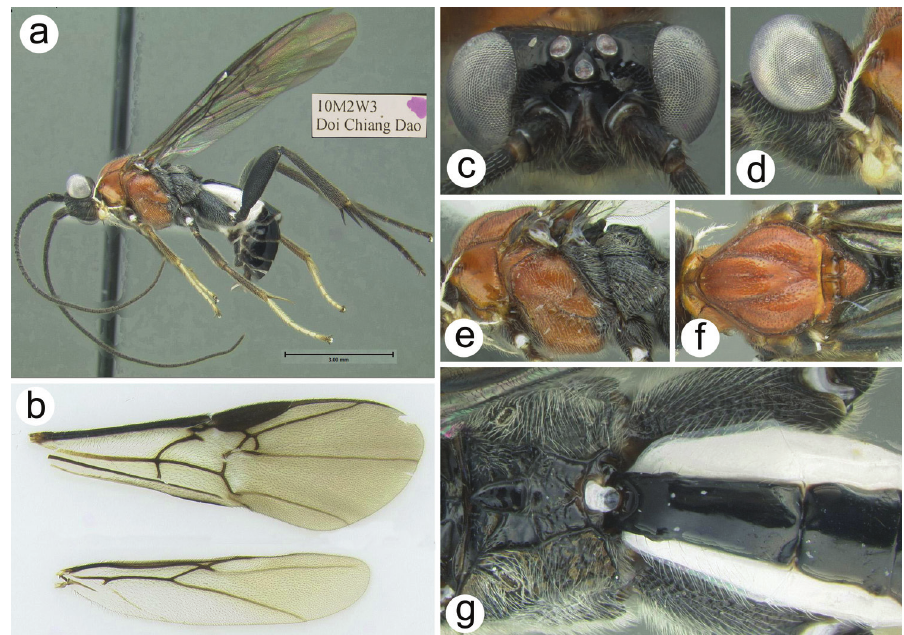
Figure 12. Zelodia panyaii sp.n. a lateral habitus b wings c dorsal head d lateral head e lateral mesosoma f dorsal mesosoma g dorsal propodeum and MT1 and of widest point of MT1 to narrowest point 0.505/0.421 = 1.2. Color. Black, reddish orange, brown, cream colored and white: mostly black, reddish orange as follows: pro and mesothorax, most of fore leg; mid leg mostly brown; fore and mid tarsi yellow; mouthparts cream colored and yellow, anterior laterotergites and sterna white.